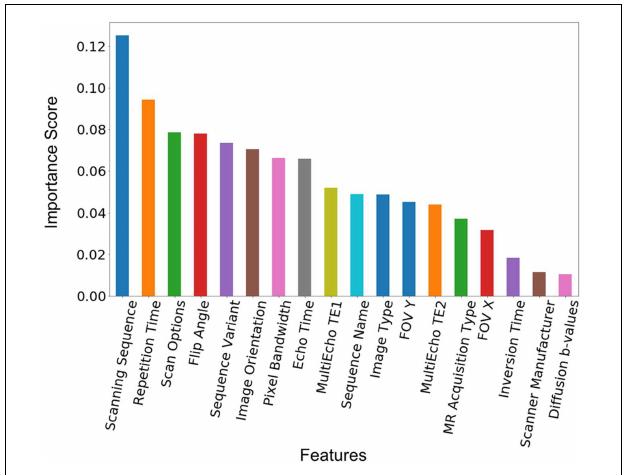
FIGURE 3 | Feature importance score. The feature importance score was extracted from a model built from the training data with 1,200 scans from each of the sequence types 1–7 in Table 2 . The features are ranked by the value of the importance score. The corresponding DICOM tags of these features can be seen in Table 3